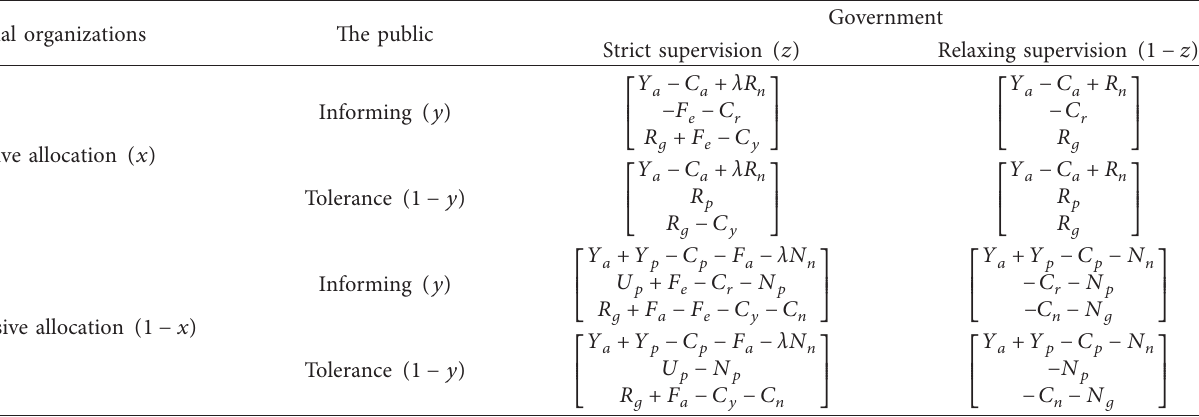
Table 1: The payoff